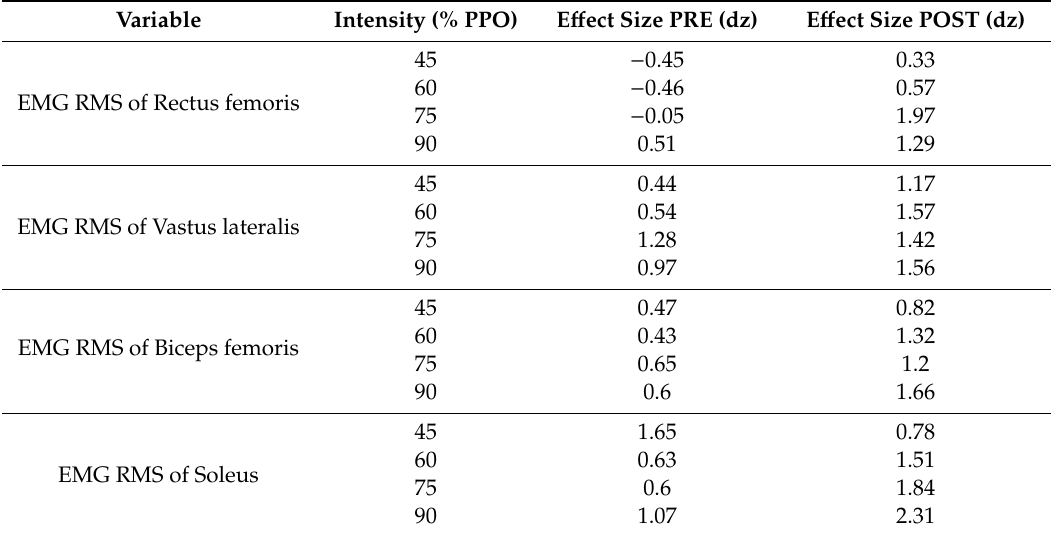
Table 1. Intraindividual e ff ect sizes for muscle activity before and after the cycling sessions. Variable Intensity (% PPO) E ff ect Size PRE (dz) E ff ect Size POST (dz) 45 − 0.45 0.33 60 − 0.46 0.57 EMG RMS of Rectus femoris 75 − 0.05 1.97 90 0.51 1.29 45 EMG RMS of Vastus lateralis